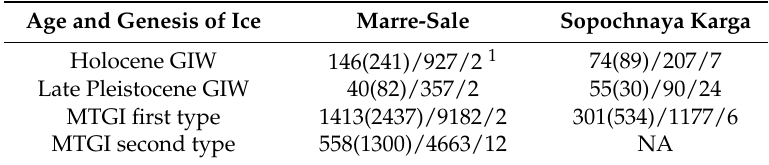
Table 1. Methane concentration (ppmV) in air bubbles of ground ice wedges (GIW) and massive tabular ground ice (MTGI) of Marre-Sale and Sopochnaya